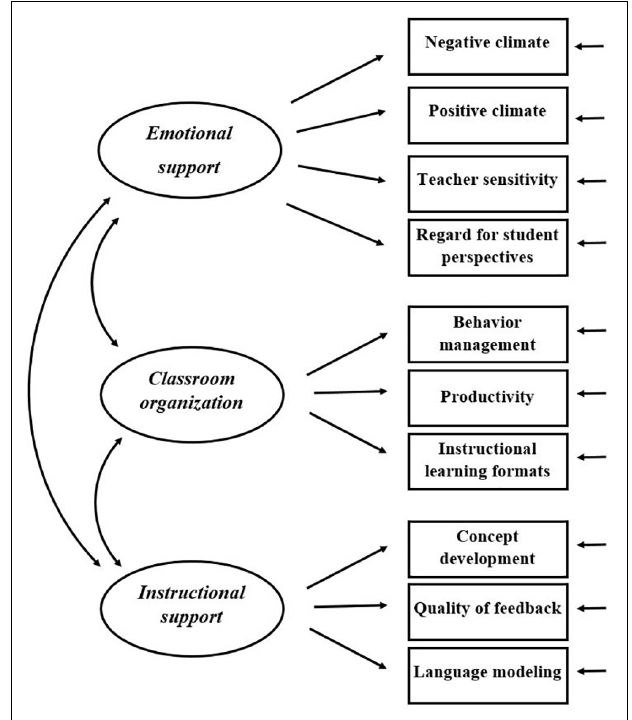
FIGURE 1 | The three-factorial structure of the CLASS Pre-K as conceptualized by the teaching through interaction model (Pianta et al.,